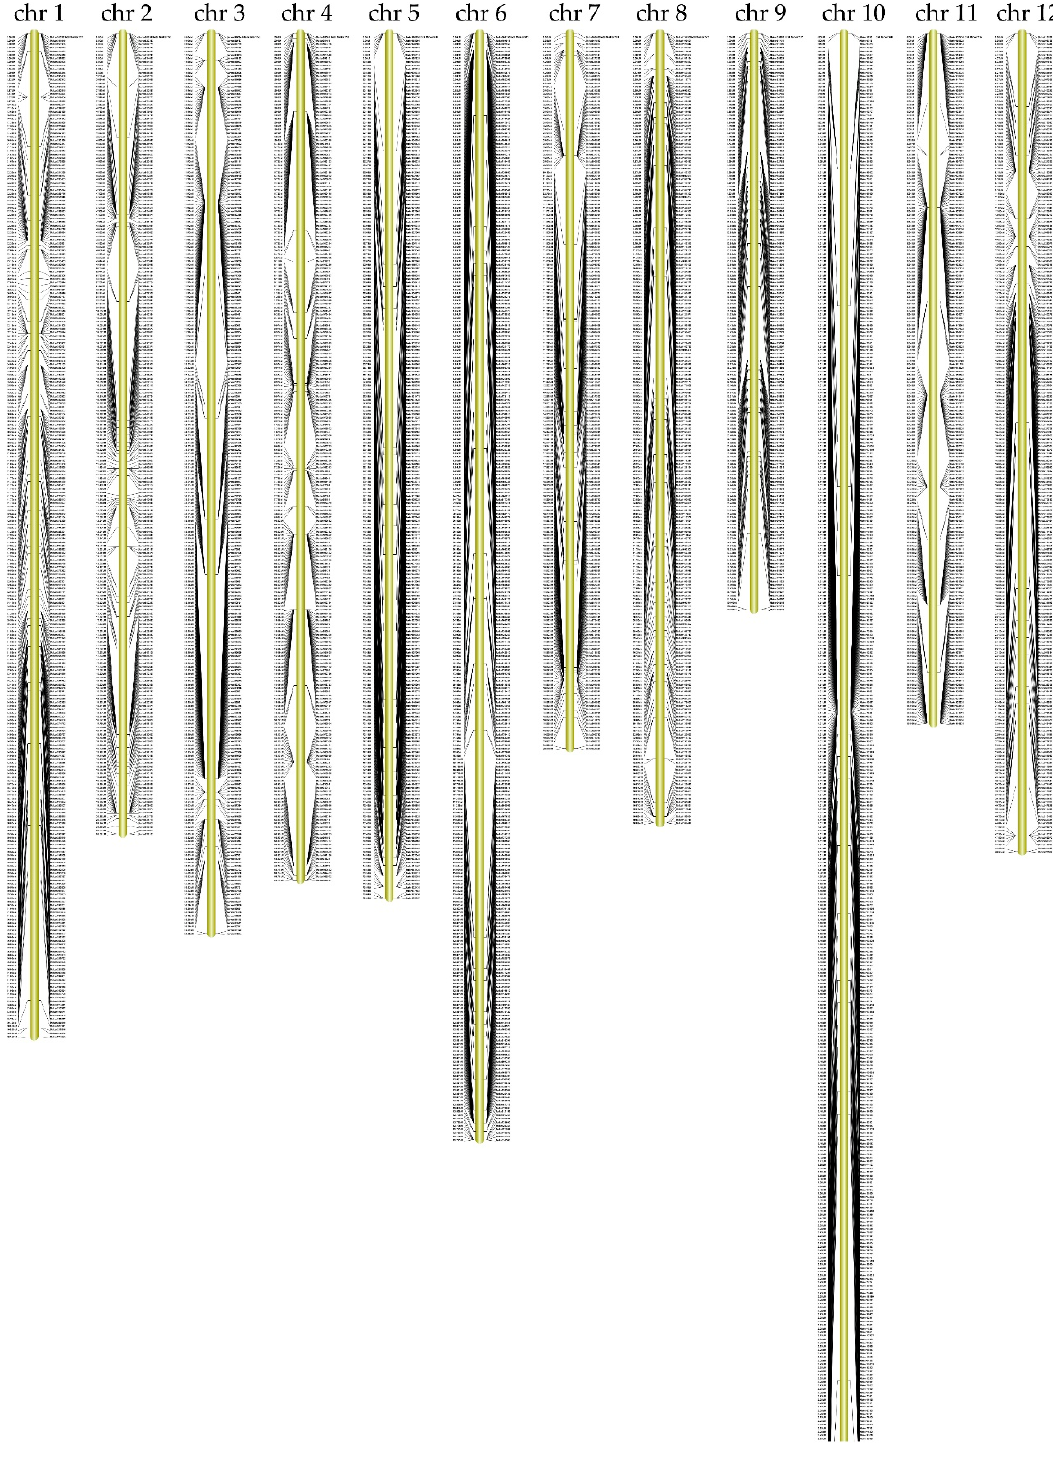
Figure 1. The high-density integrated genetic map of tetraploid potato. A total of 3001 SNP markers were distributed in 12 linkage groups, covering 1415.88 cM, with an average interval of 0.47 cM between markers.